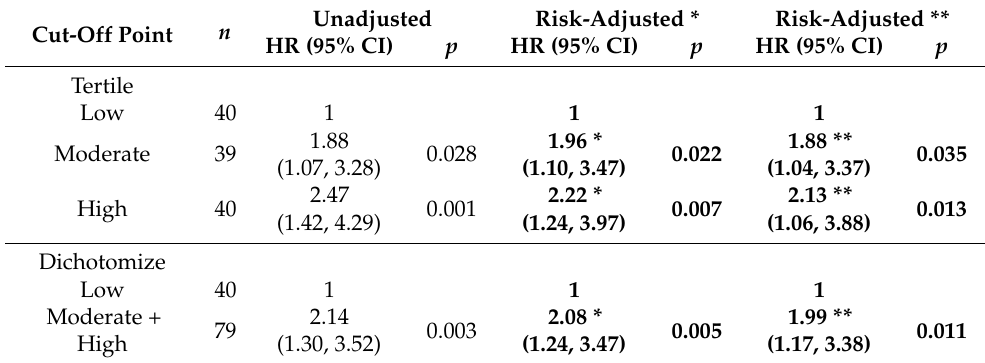
Table 3. Hazard ratio (HR) of 119 ESCC patients categorized by tertile of serum elafin levels. Cut-Off